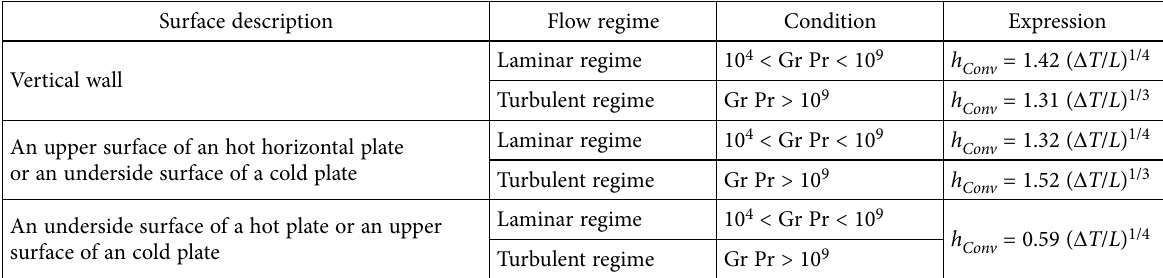
Table 1. Expression of convective transfer coefficients (George 1999)